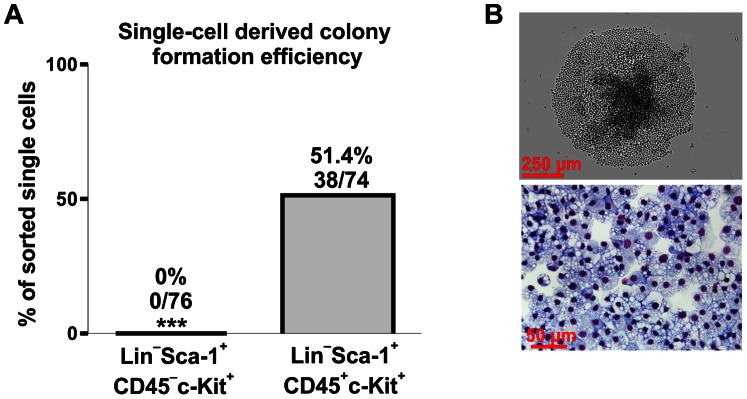
Verification of hematopoietic potential of Lin−Sca-1+CD45−c-Kit+ or Lin−Sca-1+CD45+c-Kit+ (positive control) cells by single cell-derived colony in-vitro assay.(A) Quantitative analysis of colony formation efficacy. (B) Example of a colony formed by Lin−Sca-1+CD45+cKit+ cells (contrast-phase microscopy and Wright’s staining) containing relatively homogenous progeny. *** - p<0.001 versus Lin−Sca-1+CD45+c-Kit+ cells.